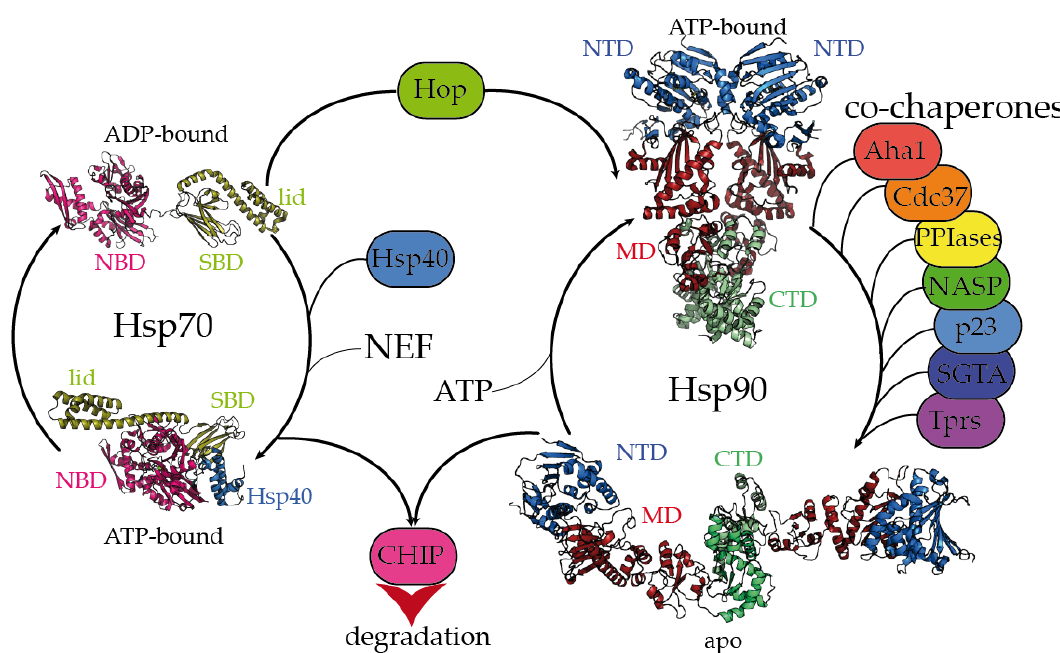
Figure 1. Hsp70 and Hsp90 chaperones are tightly regulated by co-chaperones. Hsp70 undergoes large allosteric changes upon ATP hydrolysis and substrate binding, from an extended, ADP-bound conformation with the substrate-binding domain (SBD) closed by the lid (PDB code 2kho) [45] to a collapsed, ATP-bound conformation with the SBD opened, favoring substrate release (PDB code 5nro) [46]. NBD stands for the nucleotide-binding domain. Hsp40 regulates the substrate folding and ATP hydrolysis by Hsp70 (Hsp40 J domain is included in PDB 5nro in the blue ribbon representation). NEF stands for the nucleotide exchange factor. Hop (Hsp-organizing protein) promotes the transfer of the